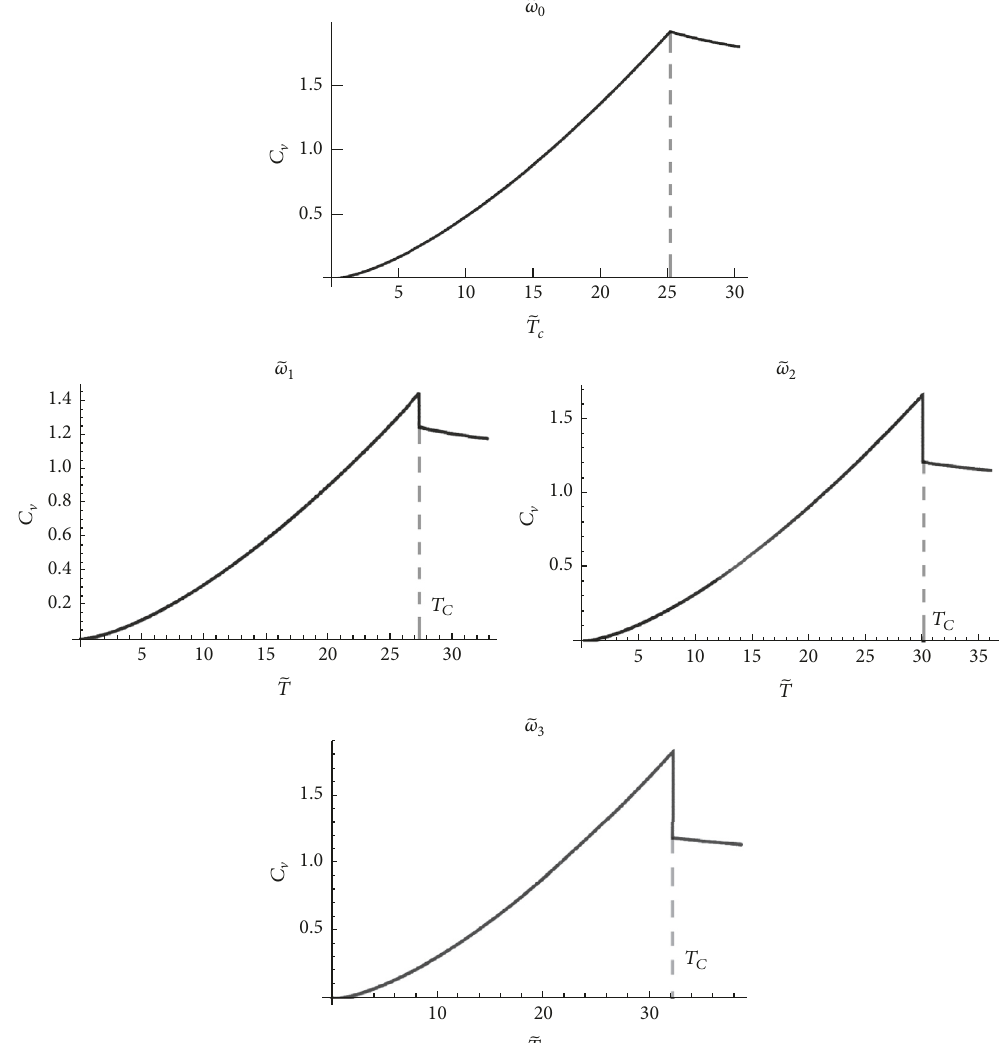
̃𝑇 (̃𝑇 = 25, 2 ; 𝐶 ) = 2 ; 𝜔 = 0, 2 ; 𝐶 0 V 𝑐1 1 (̃𝑇 = 2 ; ̃𝑇 = 32, 1 ; 𝐶 −0) = 2, 7 ; 3 𝐶 3 V 𝑐3